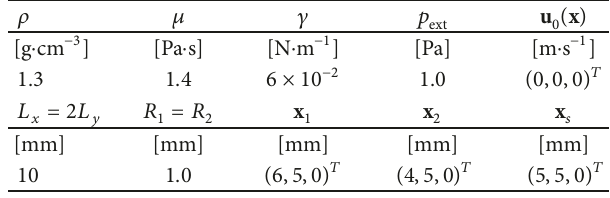
Table 1: Initial and boundary conditions imposed on the coales- cence domains ⋃ 𝑖=1,2 Ω 𝑖 . Geometrical properties used to generate the 𝑏 0 -dependent coalescence domains ⋃ 𝑖=1,2 Ω 𝑖